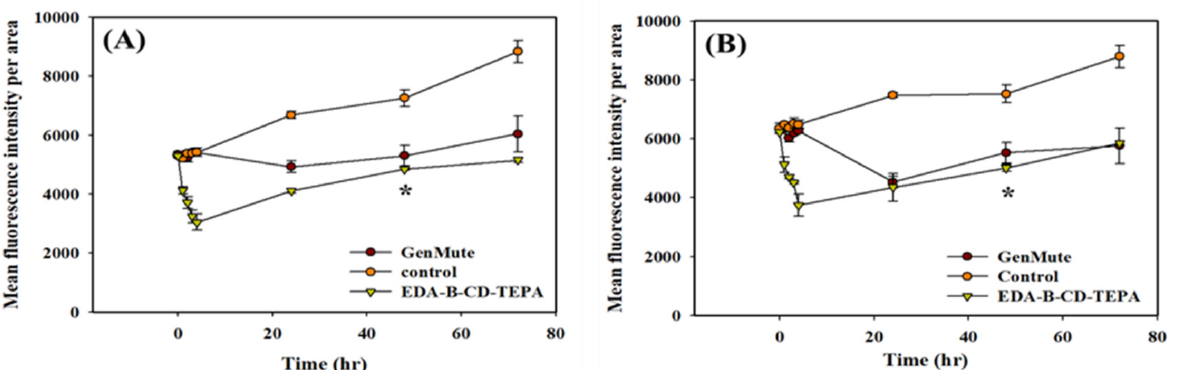
Figure 6. In vitro GFP silencing with siRNA against GFP transcripts. ARPE-GFP cells ( A ) and 3T3-GFP cells ( B ) were transfected with siRNA against GFP transcripts, using GenMute and TEPA-BCD as transfection reagents. Control groups are nontreated cells. The symbol * indicates p < 0.05 comparing TEPA-BCD to control and GenMute using ANOVA at 48 h. Error bars represent the standard deviation from 8 images. Table 1. Effects of endocytic inhibitors on DNA uptake and siRNA gene